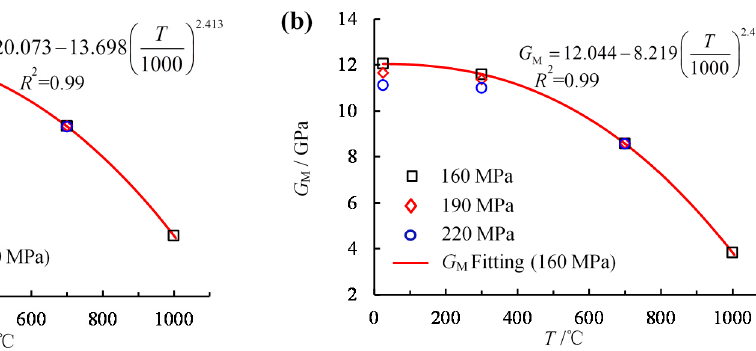
Figure 14. Relationships between the axial creep strain and the lateral creep strain at different temperatures: ( a ) 25 °C; ( b ) 300 °C; ( c ) 700 °C; ( d ) 1000 °C; ( e ) Relation between the slope of fitting line and